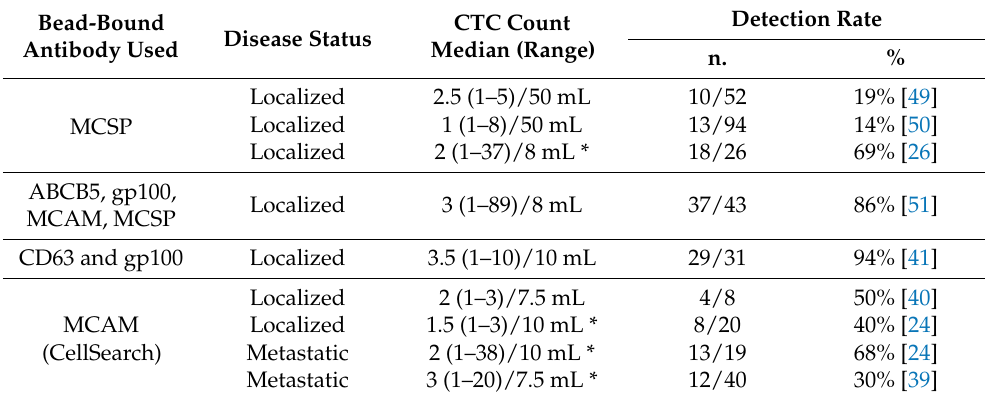
Table 1. Summary of CTC yield per bead-bound antibody (combination) used for isolating CTCs from peripheral blood in patients with either localized or metastatic UM. Median marked with an * is calculated from available data. Abbreviations: MCSP: melanoma-associated chrondroitin sulfate proteoglycan; ABCB5: ATP-binding cassette sub-family B member 5; gp100: glycoprotein 100; MCAM: melanoma cell adhesion